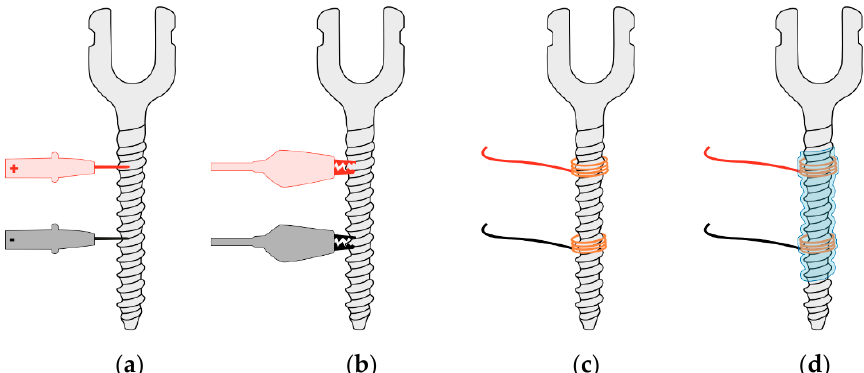
Figure 3. Illustration of the coupling methods applied to measure the voltage across the pedicle screw with the use of ( a ) multimeter probes, ( b ) alligator clips, ( c ) wrapped wires and ( d ) encapsulated wires within a thermo-retractable sleeve.